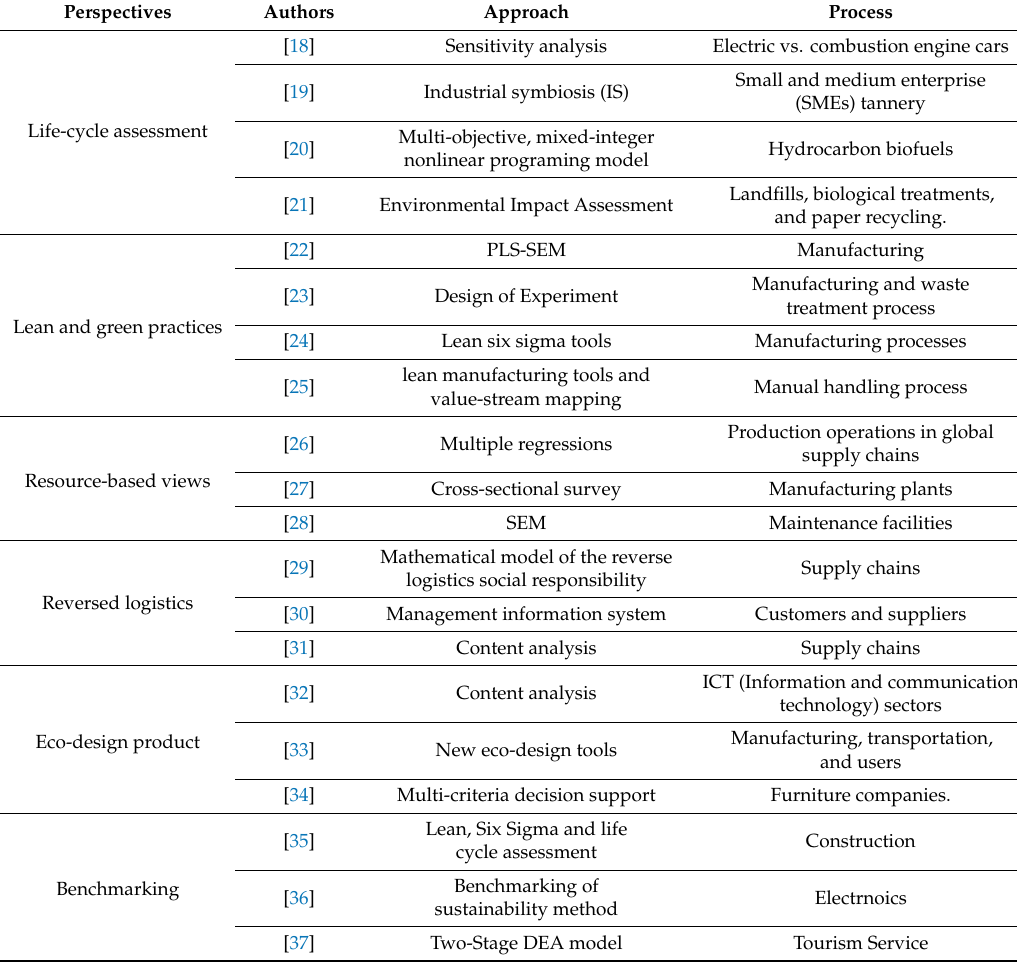
Table 1. Sustainability related